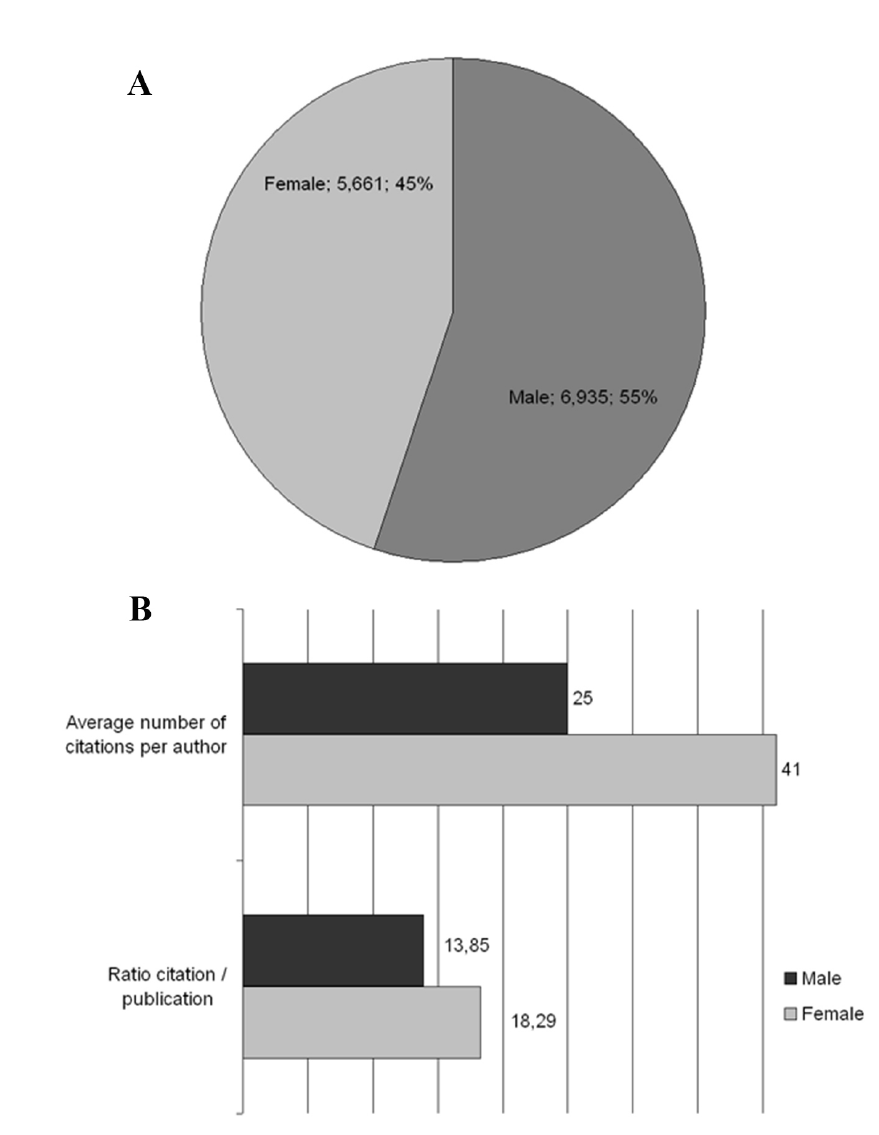
Figure 4. Gender analyses. ( A ) Proportional distribution of the gender of authors; ( B ) Average number of citations per author and ratio citation/publication of the gender of the